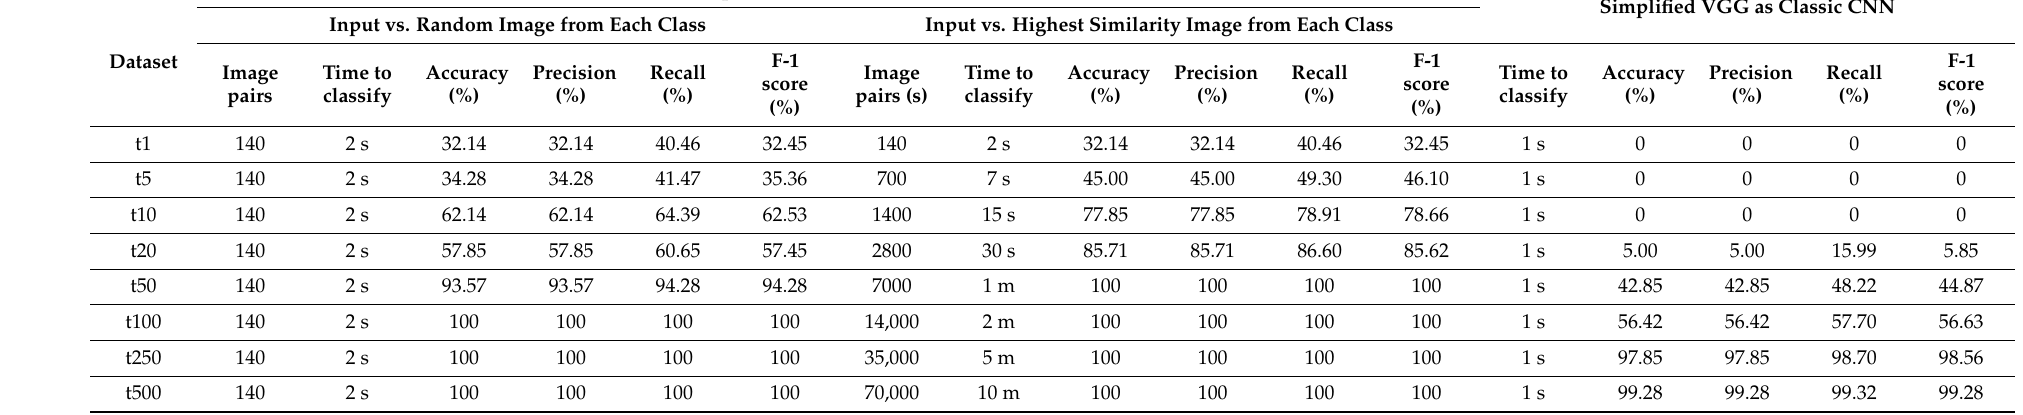
Table 7. Comparison of Siamese CNN and classic CNN conducted on dataset 2 (7-type chart classification). Both networks use the same dataset for training and verification. Regarding the average classification accuracy and F-1 score, when small datasets are used, Siamese CNN outperforms classic CNN. When comparing the required time for image classification, classic CNN is the